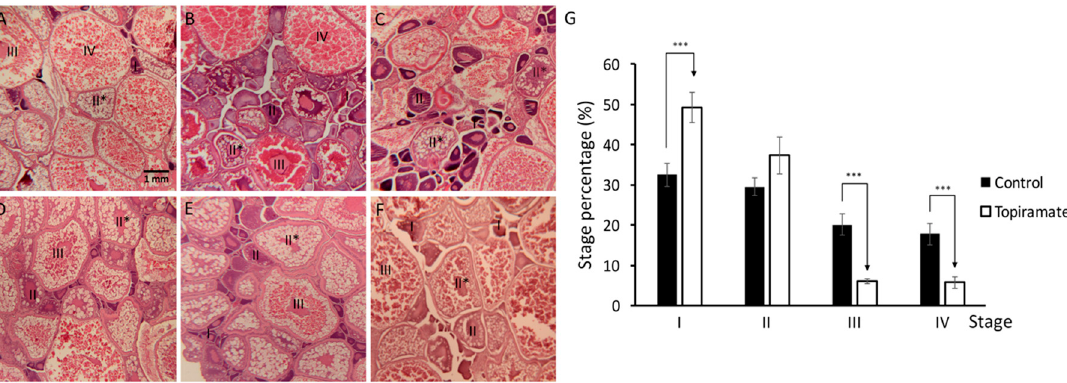
Figure 1. Under-maturation of oogenesis was shown in topiramate-treated female fish. Developmental status of oocyte in maternal fish was determined by Hematoxylin and eosin (H & E) staining. ( A ) Generally, the ovary was filled with mature oocytes in control fish in a high percentage; ( B – F ) however, a decreased percentage of mature oocytes was detected in different topiramate-treated female fish. Identification of the maturation stage was based on morphologies (I, primary growth stage; II, early cortical alveolus stage; II *, mid-cortical alveolus stage III, vitellogesis stage; IV, mature oocyte); ( G ) statistical analysis of oogenesis stages. Columns represent the number of cells at the four stages as percentages of the total counted (averages ± SD; *** p < 0.005; control n = 8; topiramate-treated n = 7).